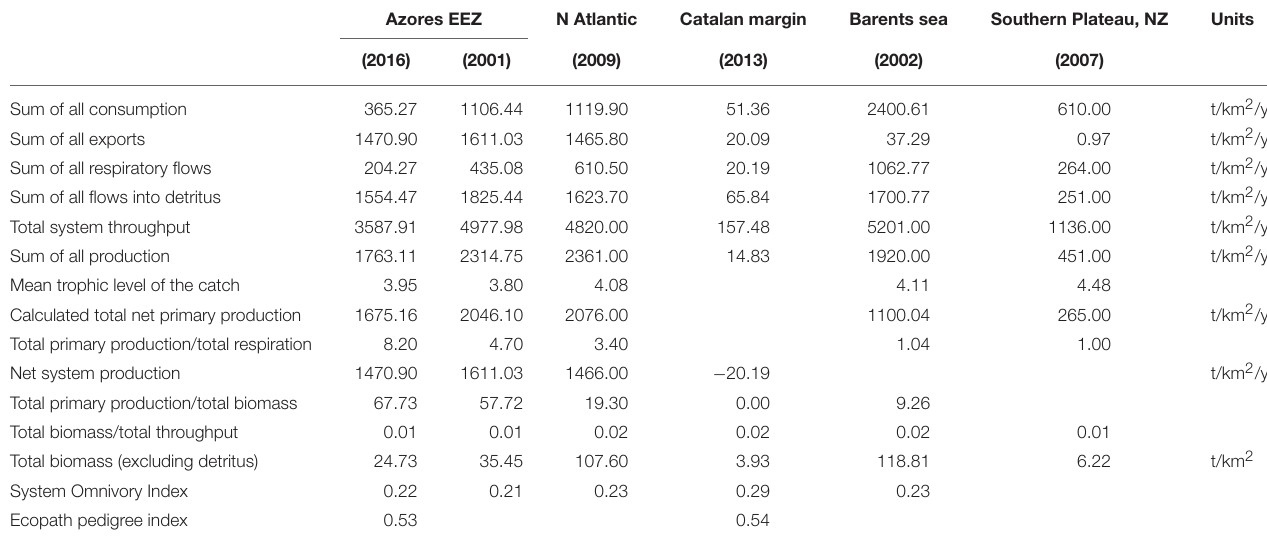
TABLE 2 | Summary ecosystem statistics calculated for the present model of the Azores exclusive economic zone (Azores EEZ, 2016), with statistics reported for other deep-sea ecosystem dominated models: Azores EEZ (Guénette and Morato, 2001), North Atlantic sea theoretical seamount